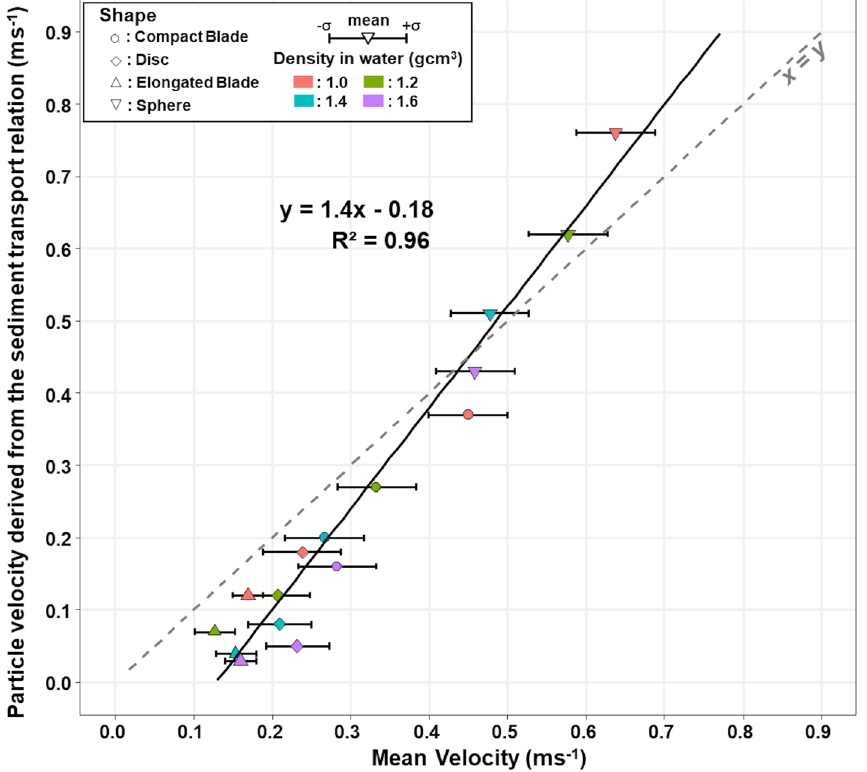
Figure 6. Comparison between the mean measured velocities of particles of various shapes and densities and the theoretical particle velocity derived from a fractional transport rate relation adapted from Wilcock and Crowe’s (2003) relation